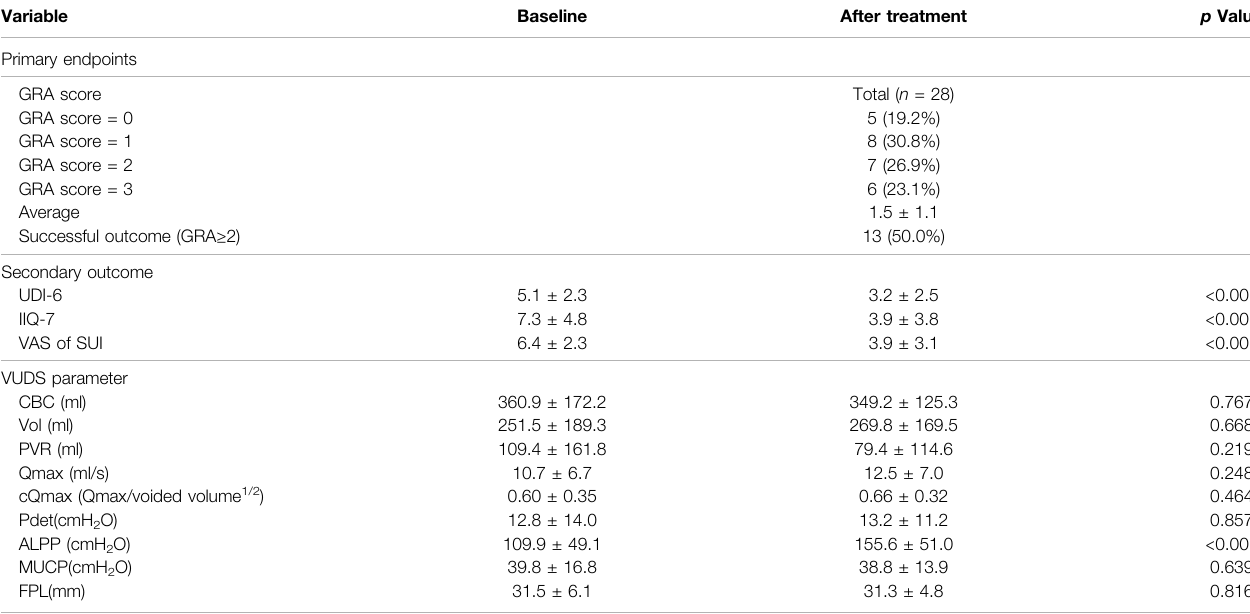
TABLE 2 | Clinical outcomes and change of urodynamic parameters after platelet-rich plasma urethral sphincter injection treatment.